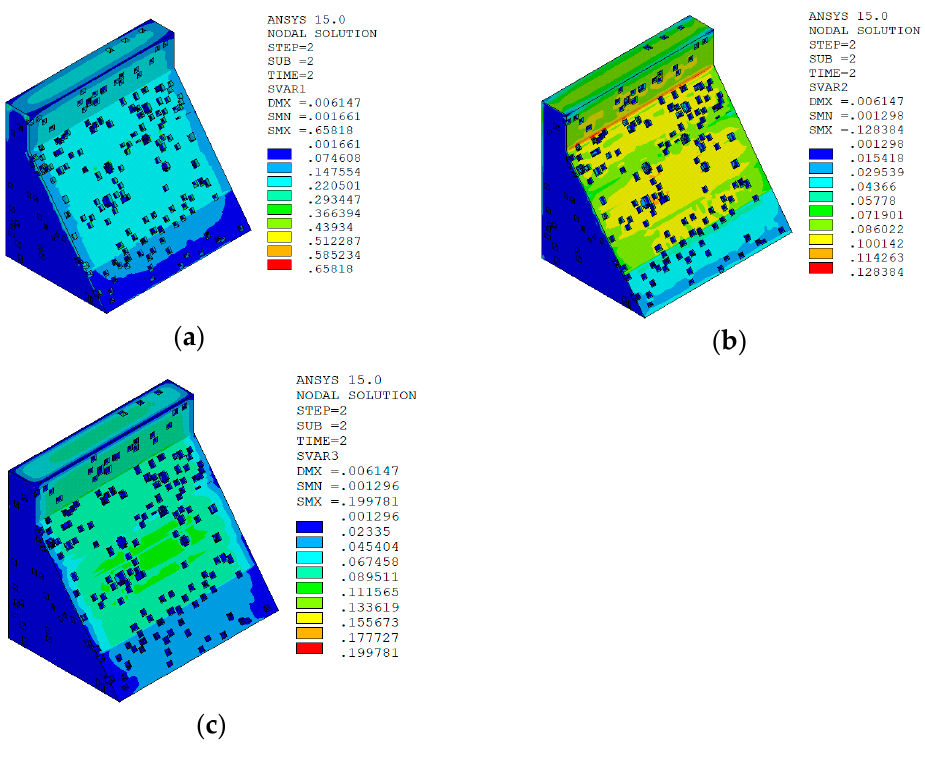
Figure 20. The temperature damage distribution of the mortar material in the three principal strain directions is calculated by the macro-meso model under the temperature rise condition, ( a ) The temperature damage distribution in the first principal strain direction, ( b ) The temperature damage distribution in the second principal strain direction, ( c ) The temperature damage distribution in the third principal strain direction.